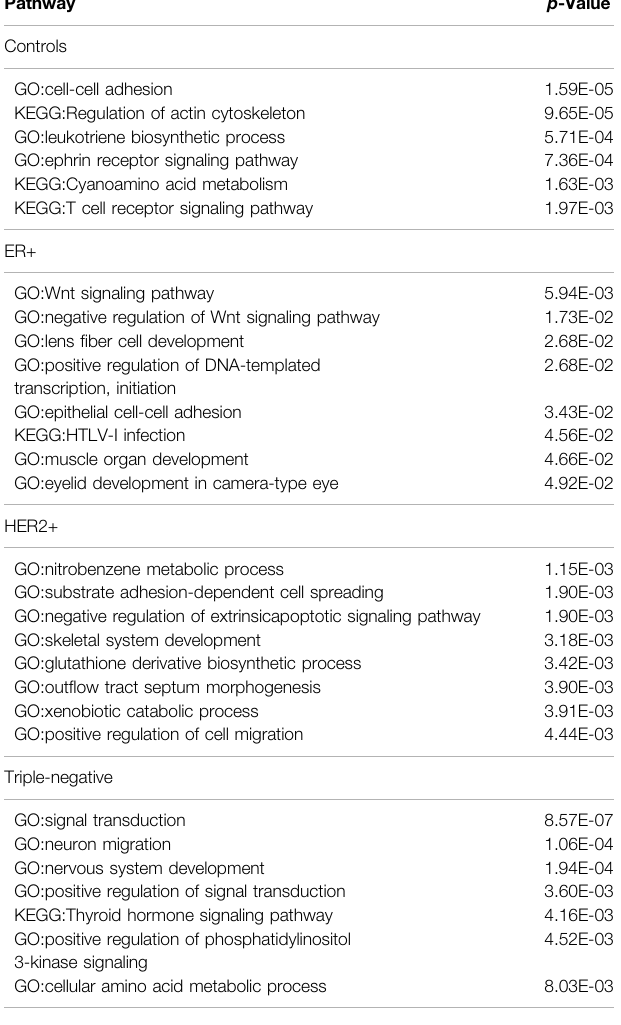
TABLE2| Themostsigni fi cantlyenrichedpathwaysbythegenesbelongingtotop 200 speci fi c edges of each molecular subtype in BRCA. Pathway p -Value